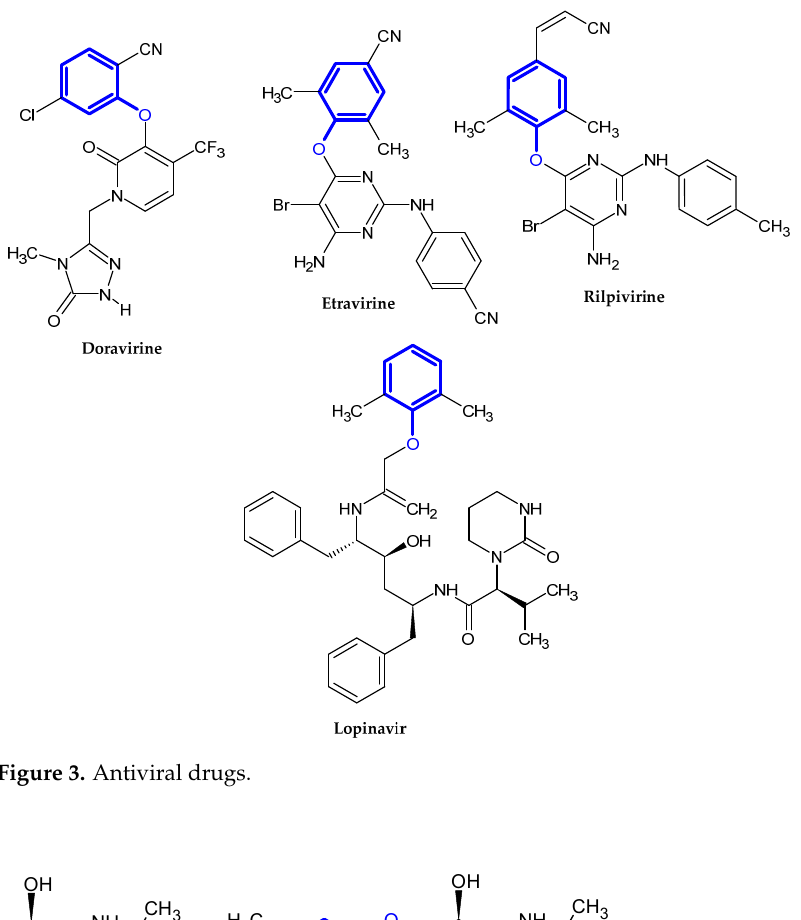
Figure 3. Antiviral drugs.